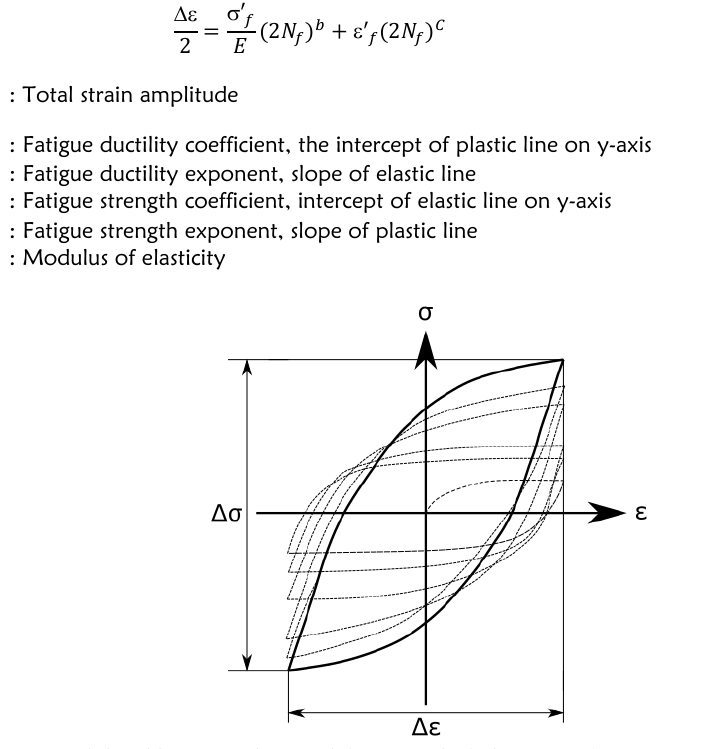
Figure 3a: A stabilized hysteresis loop exhibiting cyclic behaviour of specimen cyclically loaded.